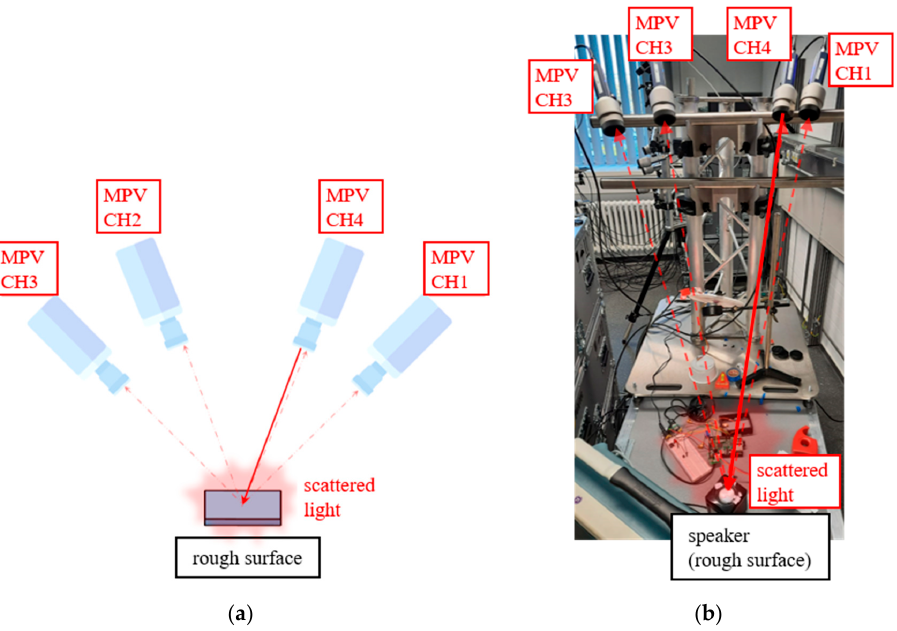
Figure 2. ( a ) Concept of the second experimental setup with one active measuring head (CH4) and three passive measuring heads (CH1–CH3); ( b ) Image of the actual test setup measuring on a